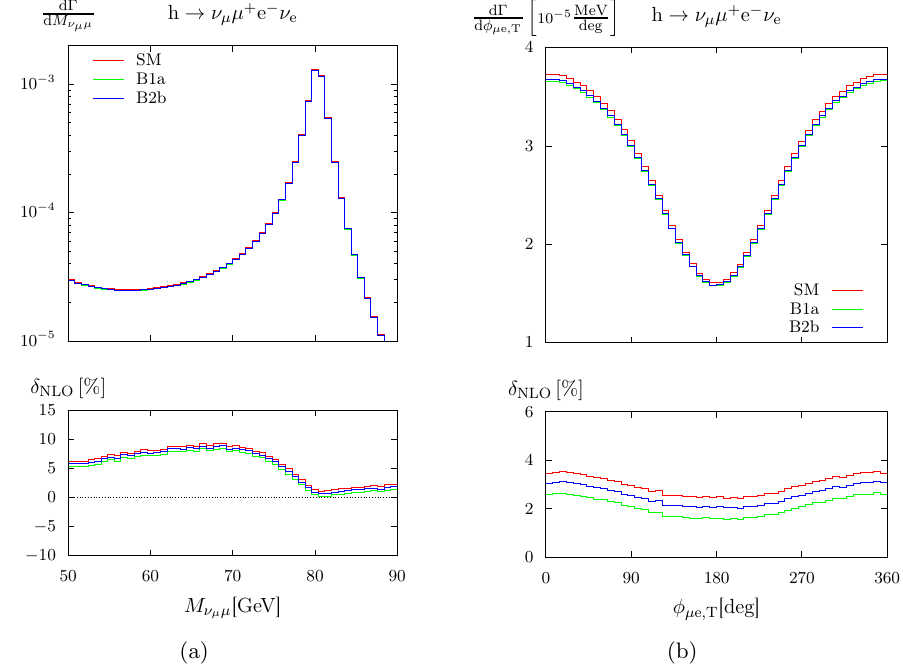
Figure 37 . Invariant-mass (a) and angular distributions (b) of the leptonic charged-current decay h (cid:23) (cid:22) (cid:22) + e (cid:0) (cid:22) (cid:23) e for the SM and the THDM scenarios B1a and B2b. The relative NLO corrections ! to the distributions are plotted in the lower